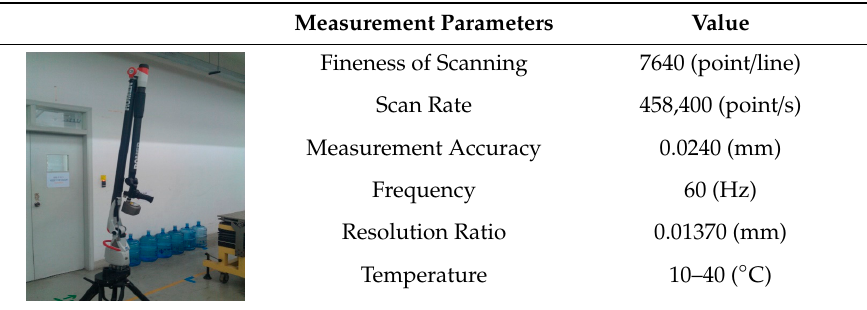
Table 1. Measurement parameters.